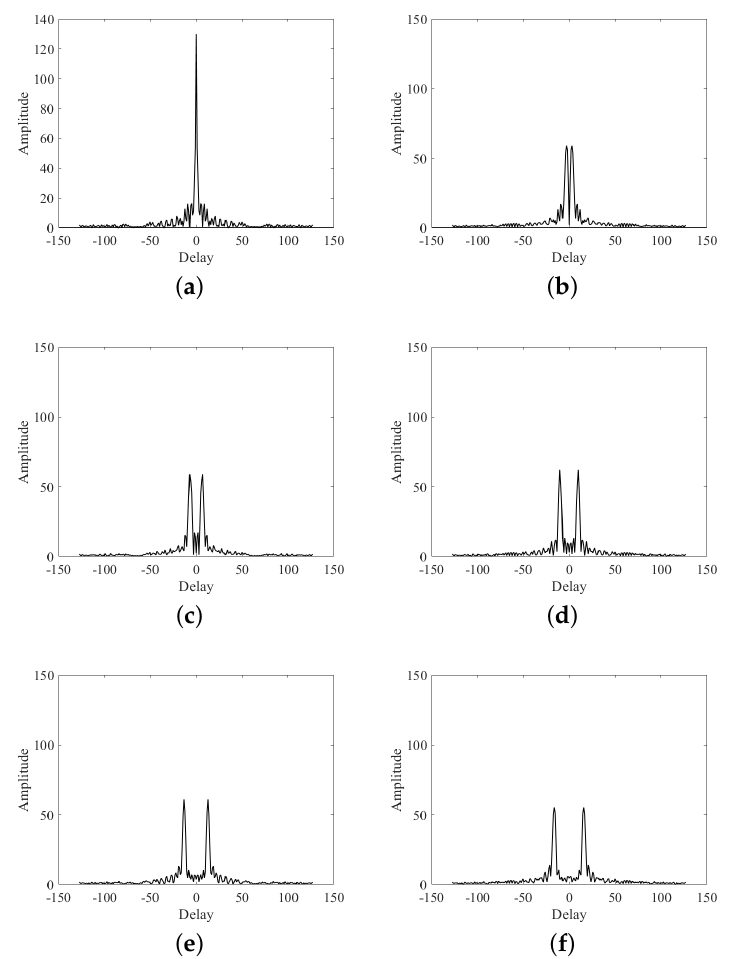
Figure 3. AF-RS in different offset. ( a ) ν = 0, ( b ) ν = 1, ( c ) ν = 2, ( d ) ν = 3, ( e ) ν = 4, ( f ) ν =